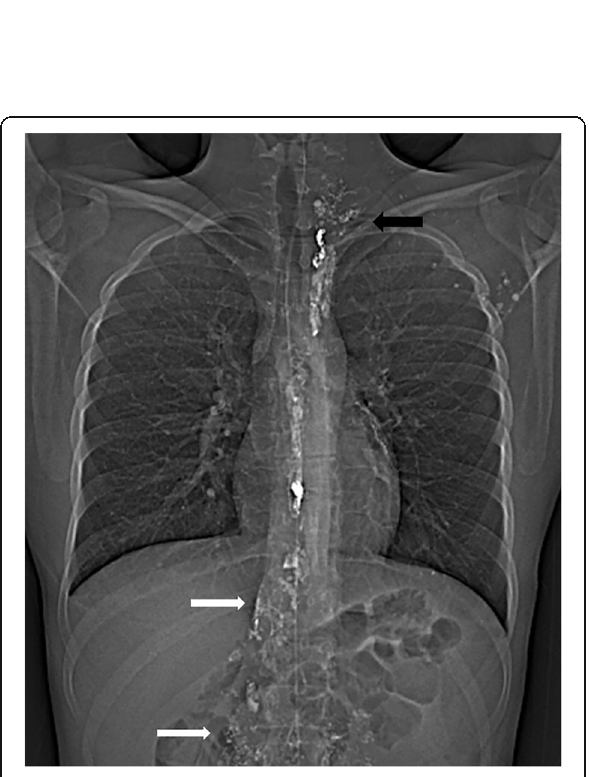
Fig. 3 Post-procedural CT topogram demonstrating embolization coils and NBCA through the length of the thoracic duct. Ethiodol also opacifies portions of the malformation in the abdomen (white arrows) and mediastinum/left neck (black arrow) along with left axillary lymph